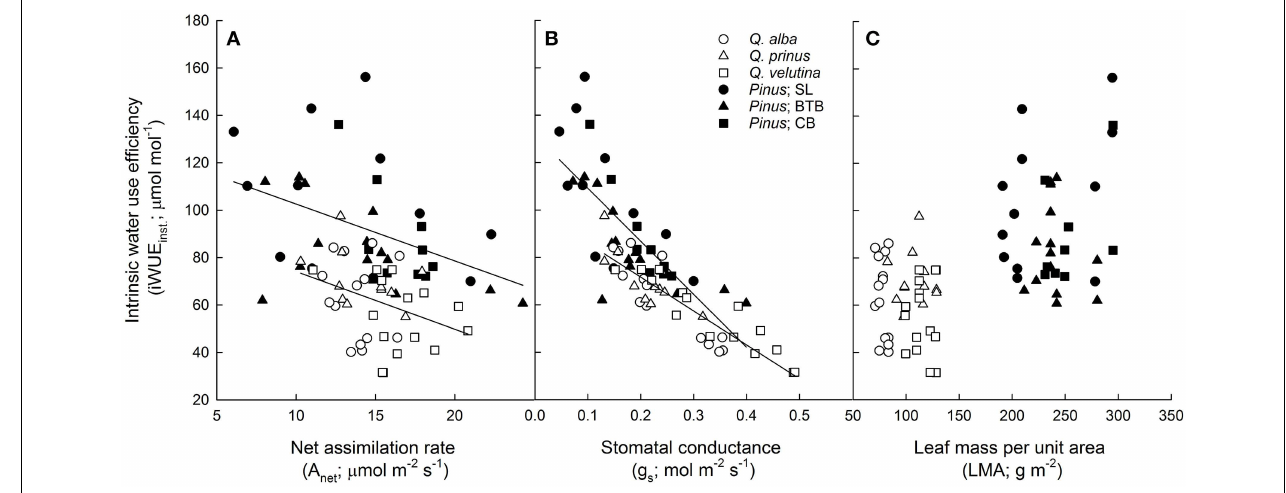
FIGURE 3 | Instantaneous intrinsic water use efficiency (iWUE inst . ; µ mol CO 2 mol − 1 H 2 O) vs. (A) net photosynthetic assimilation rate (A net ; µ mol m − 2 s − 1 ) for oaks ( y = − 2 . 4 x + 98 . 5 ; r 2 = 0 .13) and pines ( y = − 2 . 4 x + 126 . 6 ; r 2 = 0 .19), (B) stomatal conductance (g s ; mol H 2 O m − 2 s − 1 ) for oaks ( y = − 143 x + 100 . 3 ; r 2 = 0 .79) and